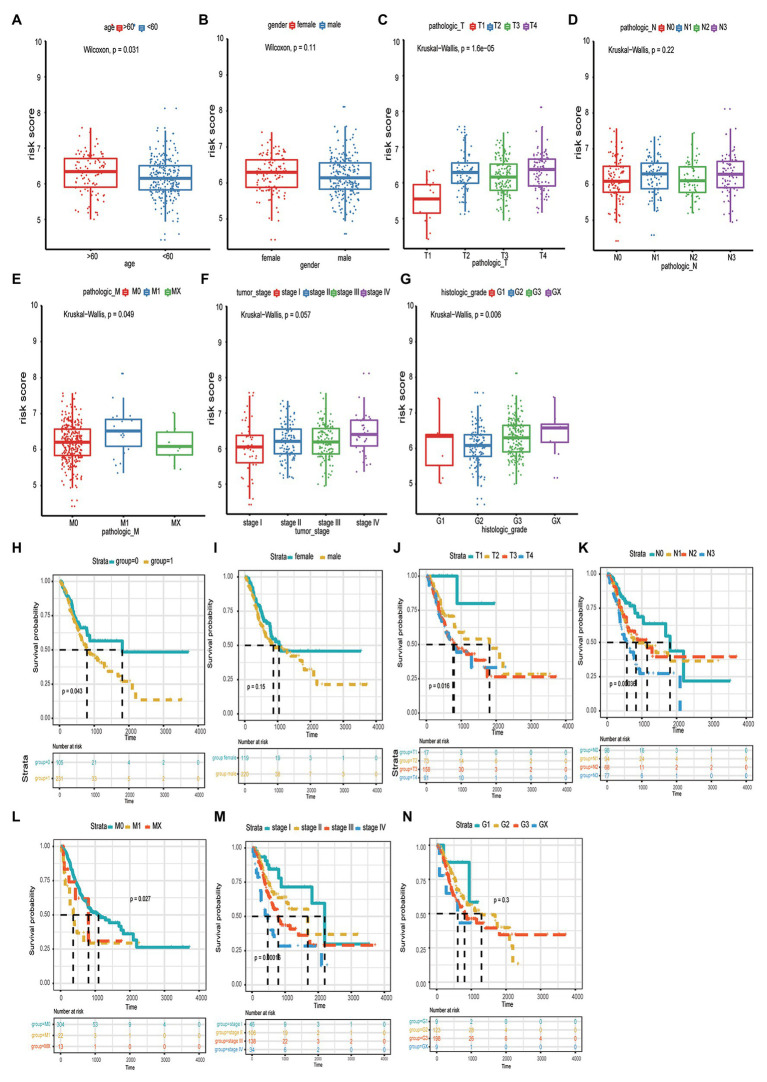
The correlation between risk score and age (A), gender (B), tumor size (C), lymphatic node metastasis (D), distant organ metastasis (E), clinical-stage (F), and histologic grade (G). The distribution of the survival curves for different clinical traits, including age (H), gender (I), pathological tumor size, node metastasis, distant metastasis (TNM) stage (J-L), clinical-stage (M), and pathological grade (N).